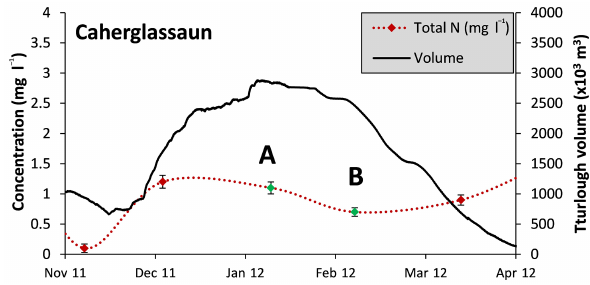
Figure 10. Denitrification example, Caherglassaun. Denitrification occurring between points A and B. Standard deviation of duplicate samples shown by error